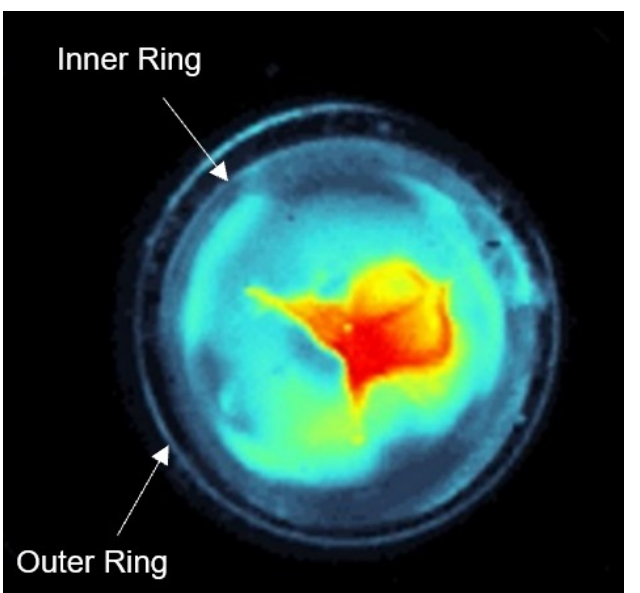
Figure 3. An outer and inner ring can be observed in the dark field image. The outer ring shows the edge of the mounting disk, in which the lens is stored in the medium and the inner ring represents the edge of the lens. the edge of the